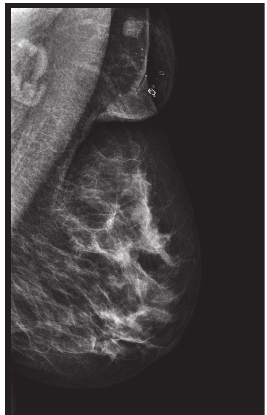
Figure 1: Nonpalpable hyperdense, lobular, and well-circumscribed nodule in ectopic axillary breast tissue in digital mammographic study.